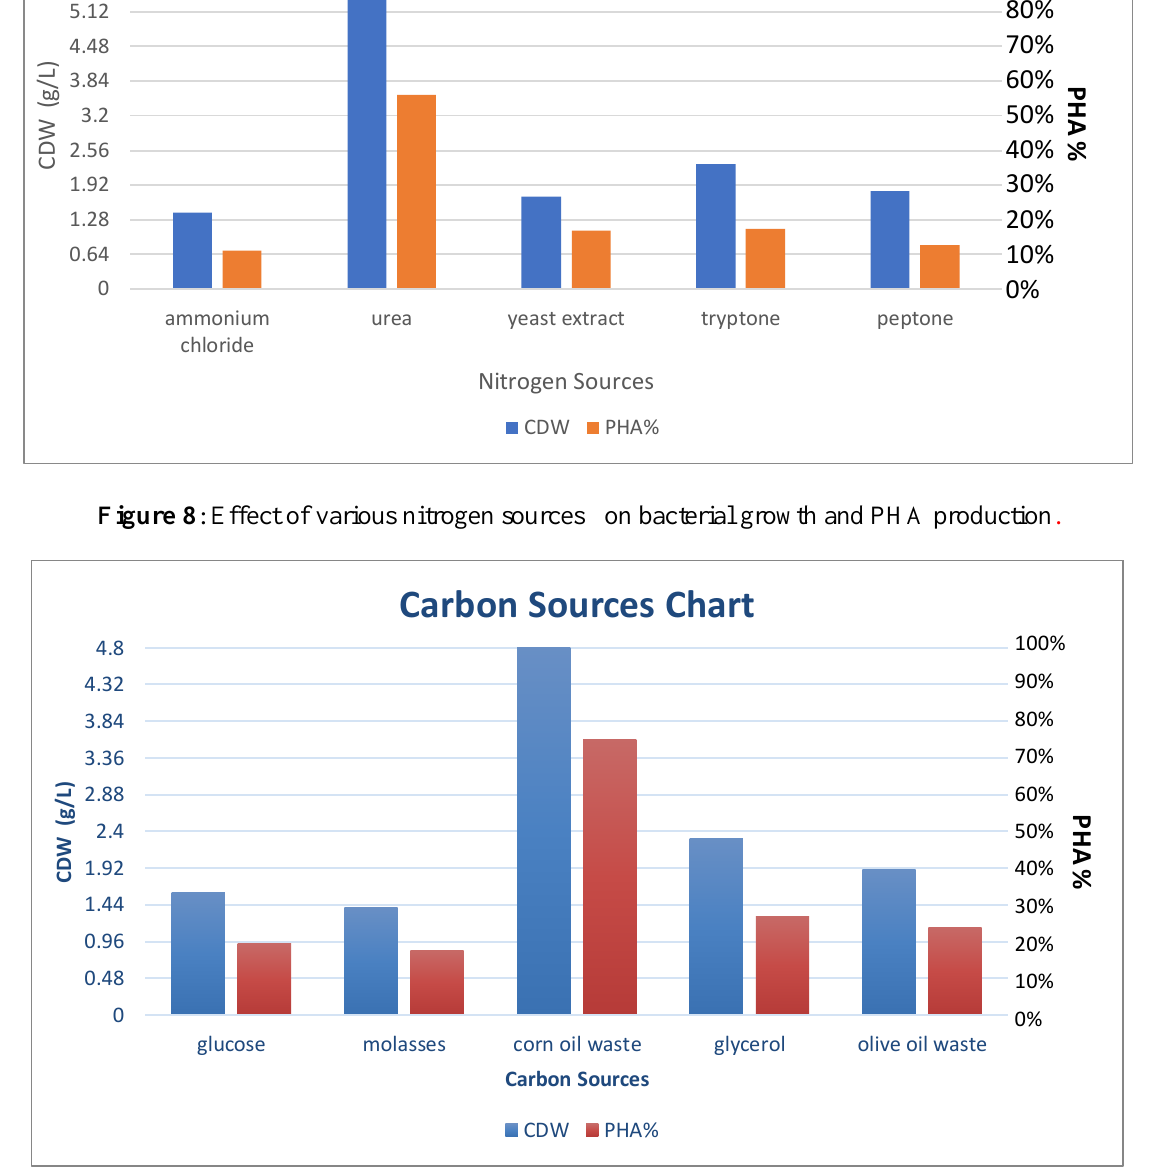
Figure 9: Effect of various carbon sources on bacterial growth and PHA production